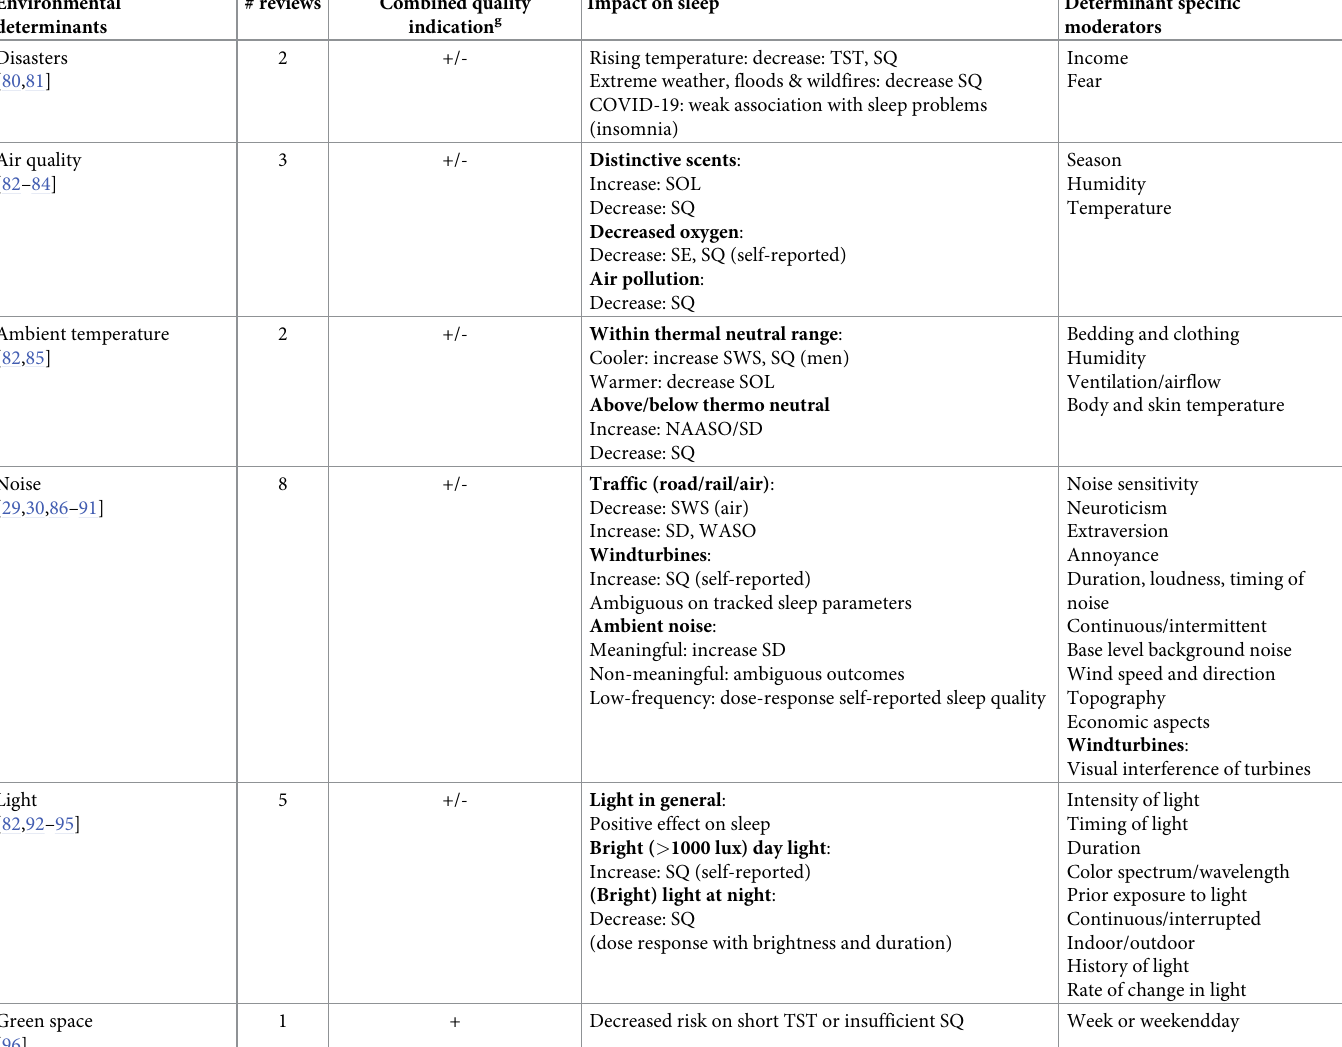
Table 5. Overview of (physical) environmental determinants of